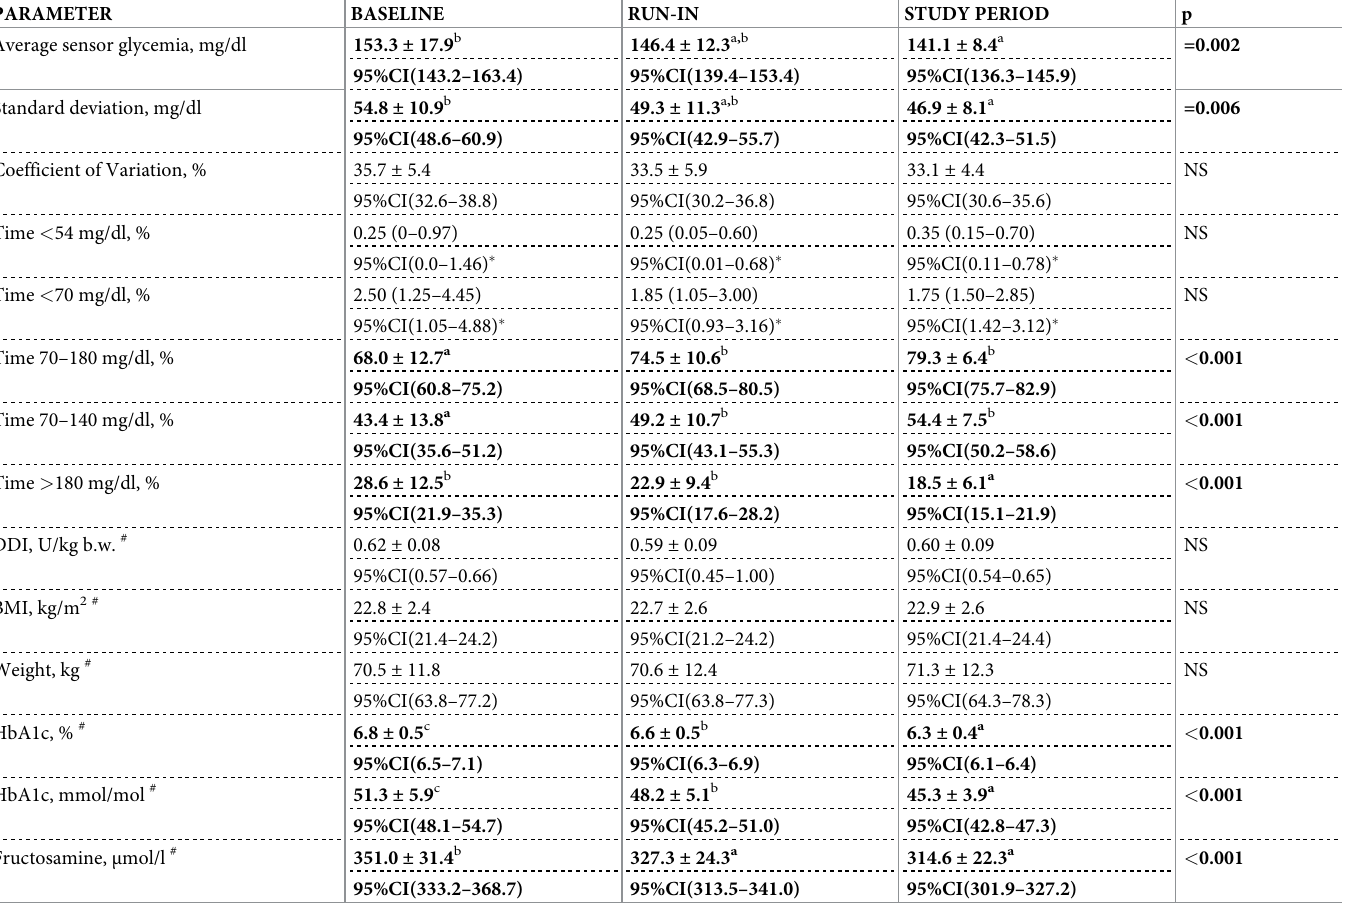
HbA1c values between all analyzed time periods. The fructosamine concentration significantly decreased at both run-in time and study period comparing to baseline time (Table 2). The body weight and daily insulin dose did not change significantly at run-in and study period as compared to the baseline. During particular visits performed every 4 weeks in the study period average sensor glyce- mia, time in target range 70–180 mg/dl and 70–140 mg/dl improved significantly as well as HbA1c level (Table 3). In the last 4 weeks of the study period mean SG was 137.6 ± 8.7, per- centage of time in range 70–180 mg/dl 82.1 ± 5.6%, percentage of time < 54 mg/dl 0.30 (0.20– 0.55) and < 70 mg/dl 1.90 (1.10–3.05). The visualization of the median SG during the last 4